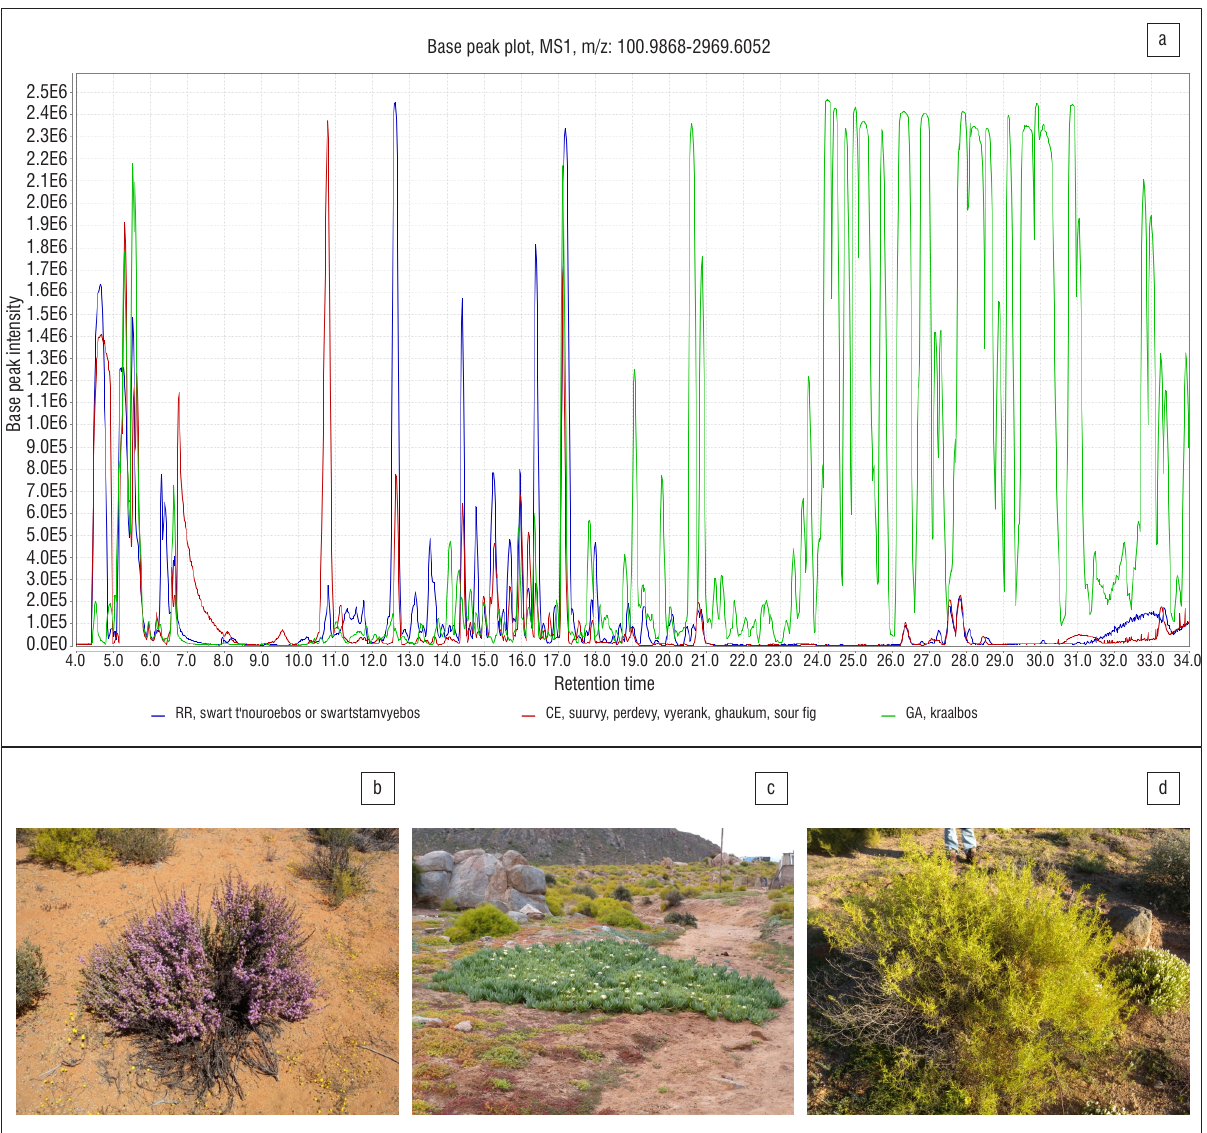
Figure 3: (a) Overlay of total ion chromatograms from liquid chromatography–mass spectrometry analyses of the ethanol extracts of Tetragonia fruticosa (red), Carpobrotus edulis (blue) and Galenia africana (green). Images of (b) T. fruticosa , (c) C. edulis and (d) G. africana